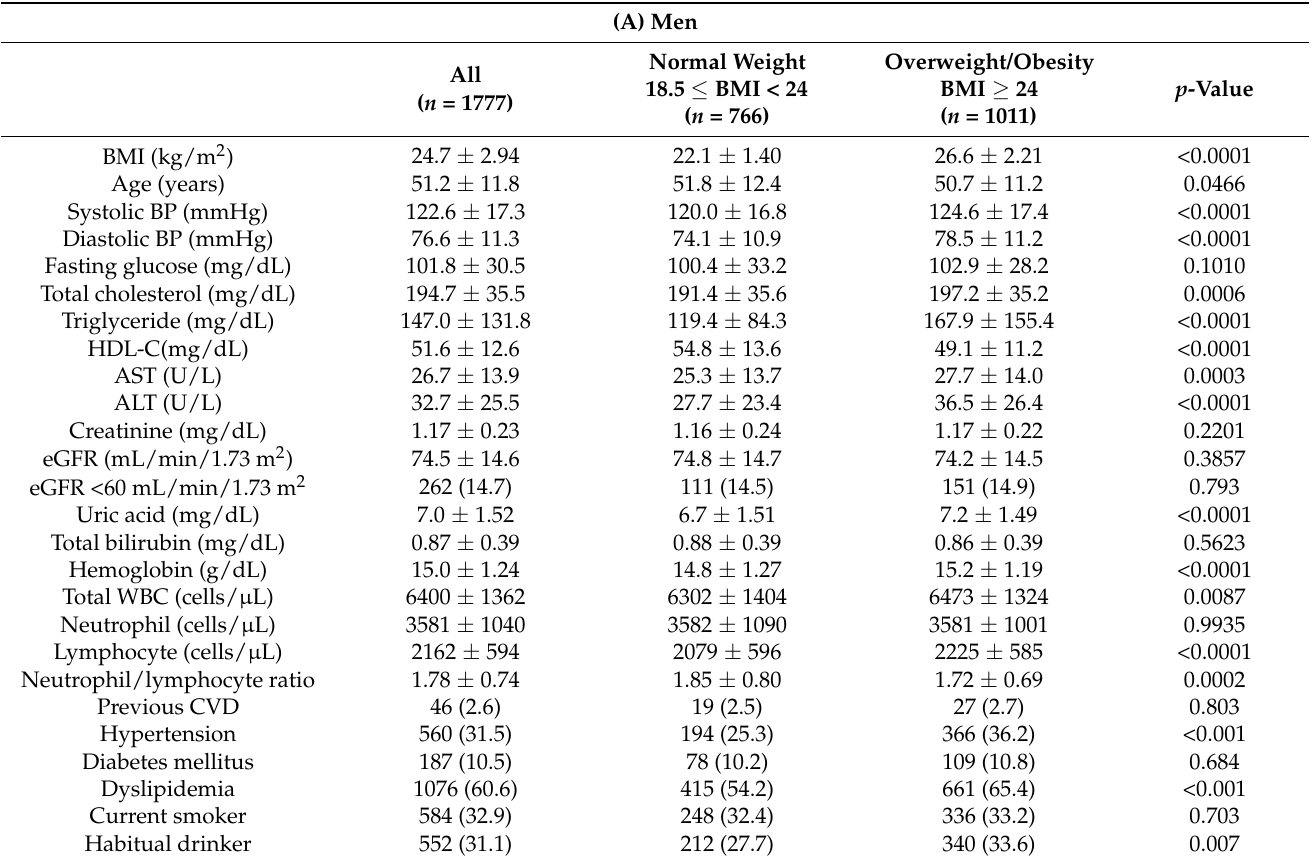
Table 1. Characteristics of Men ( A ) and Women ( B